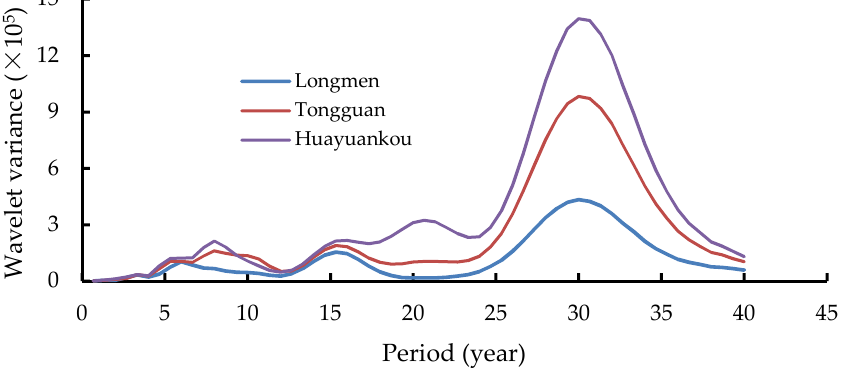
Figure 12. Wavelet variances of streamflows at Longmen, Tongguan and Huayuankou in the middle reaches.